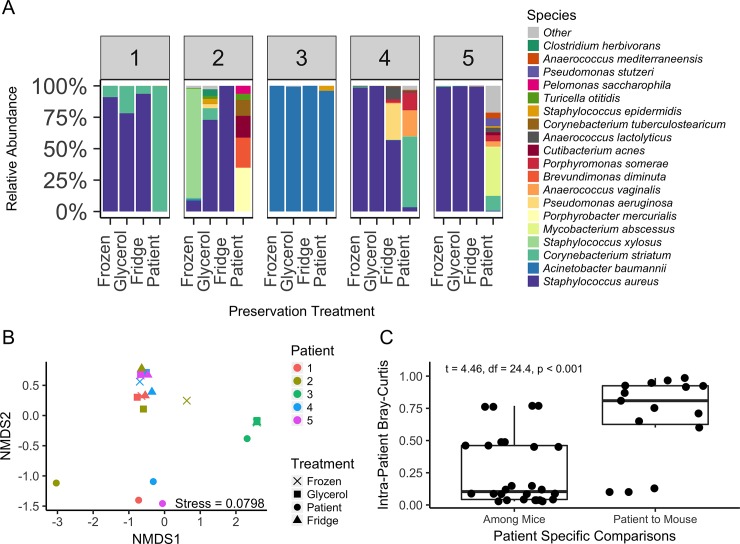
Compositional variation among wound microbiomes is influenced by host context and patient origin.Briefly, five patient wounds were sampled at the clinic. Their wound isolates were divided into three different preservation strategies per patient sample (e.g. ‘Fridge’, ‘Glycerol’, ‘Frozen’) and a fourth sample aliquot was sent directly for sequencing (‘Patient’). After preservation, sample aliquots were then used to infect surgical excision mouse wound models and sampled again at day four for sequencing. A) Relative abundance bar plot of the overall 19 most prevalent species with wounds grouped by patient isolate and each bar representing an individual mouse receiving the specified treatment. B) Compositional variation in wound microbiomes summarized using Bray-Curtis dissimilarities and non-metric multidimensional scaling (NMDS). C) Patient specific mouse-mouse and patient-mouse comparisons of microbiome compositional similarity. On the y-axis a value of 0 indicates identical communities while 1 indicates communities with no species in common.